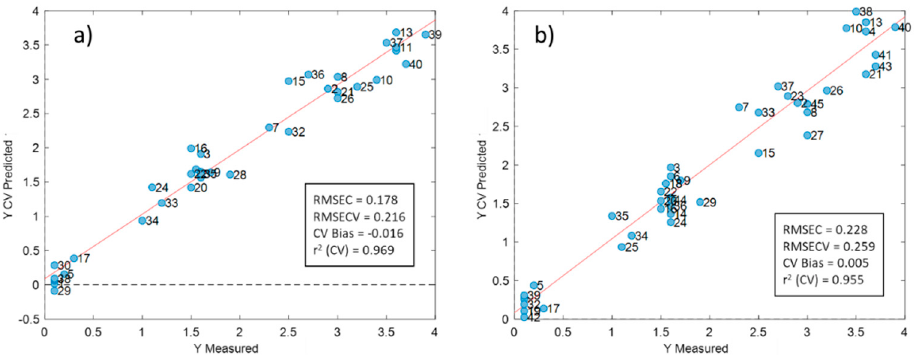
Figure 4. Regression line between the measured and predicted fat content for SCiO ( a ) and NeoSpectra ( b ). Table 1. Comparison of the best partial least squares (PLS) models obtained with di ff erent pre-treatments for the prediction of fat. Errors are expressed as % fat (g / 100 mL). Apart from the listed pre-treatments, all the models were finally mean centred. Best models are indicated with *. LVs = Latent Variables